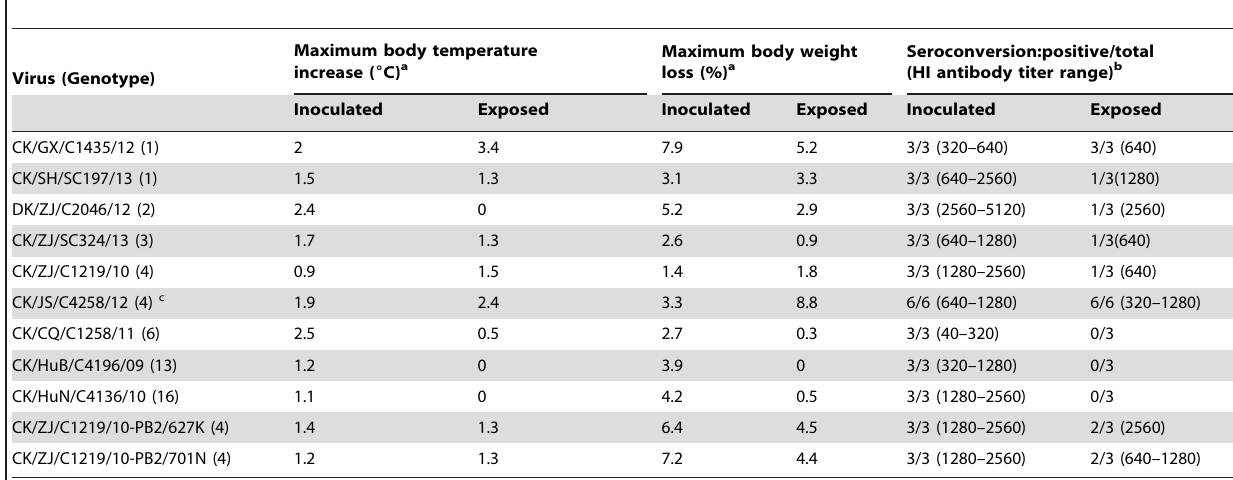
Table 1. Virus replication in and seroconversion of ferrets inoculated with or exposed to different H9N2 influenza viruses.